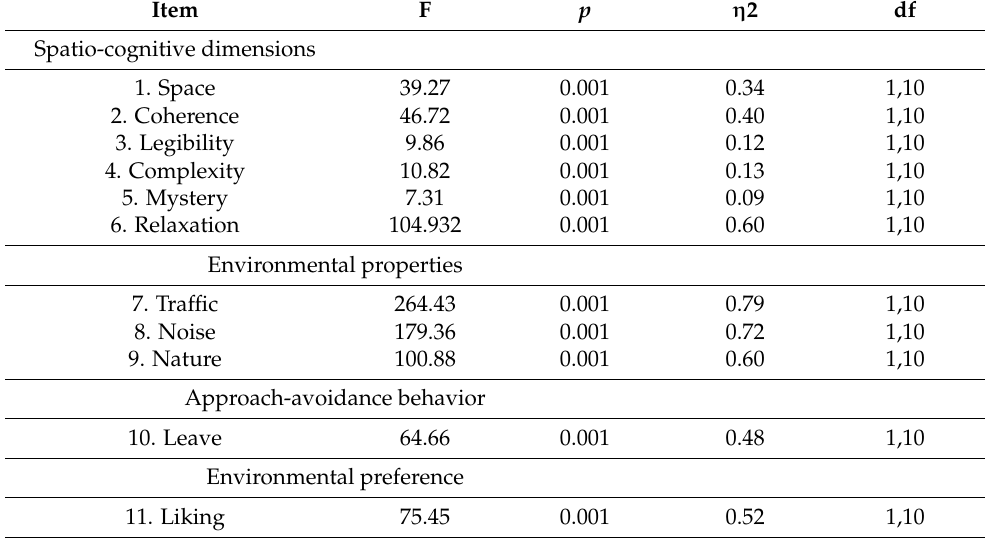
Table 3. Results of the ANOVA for all questionnaire items used in Study